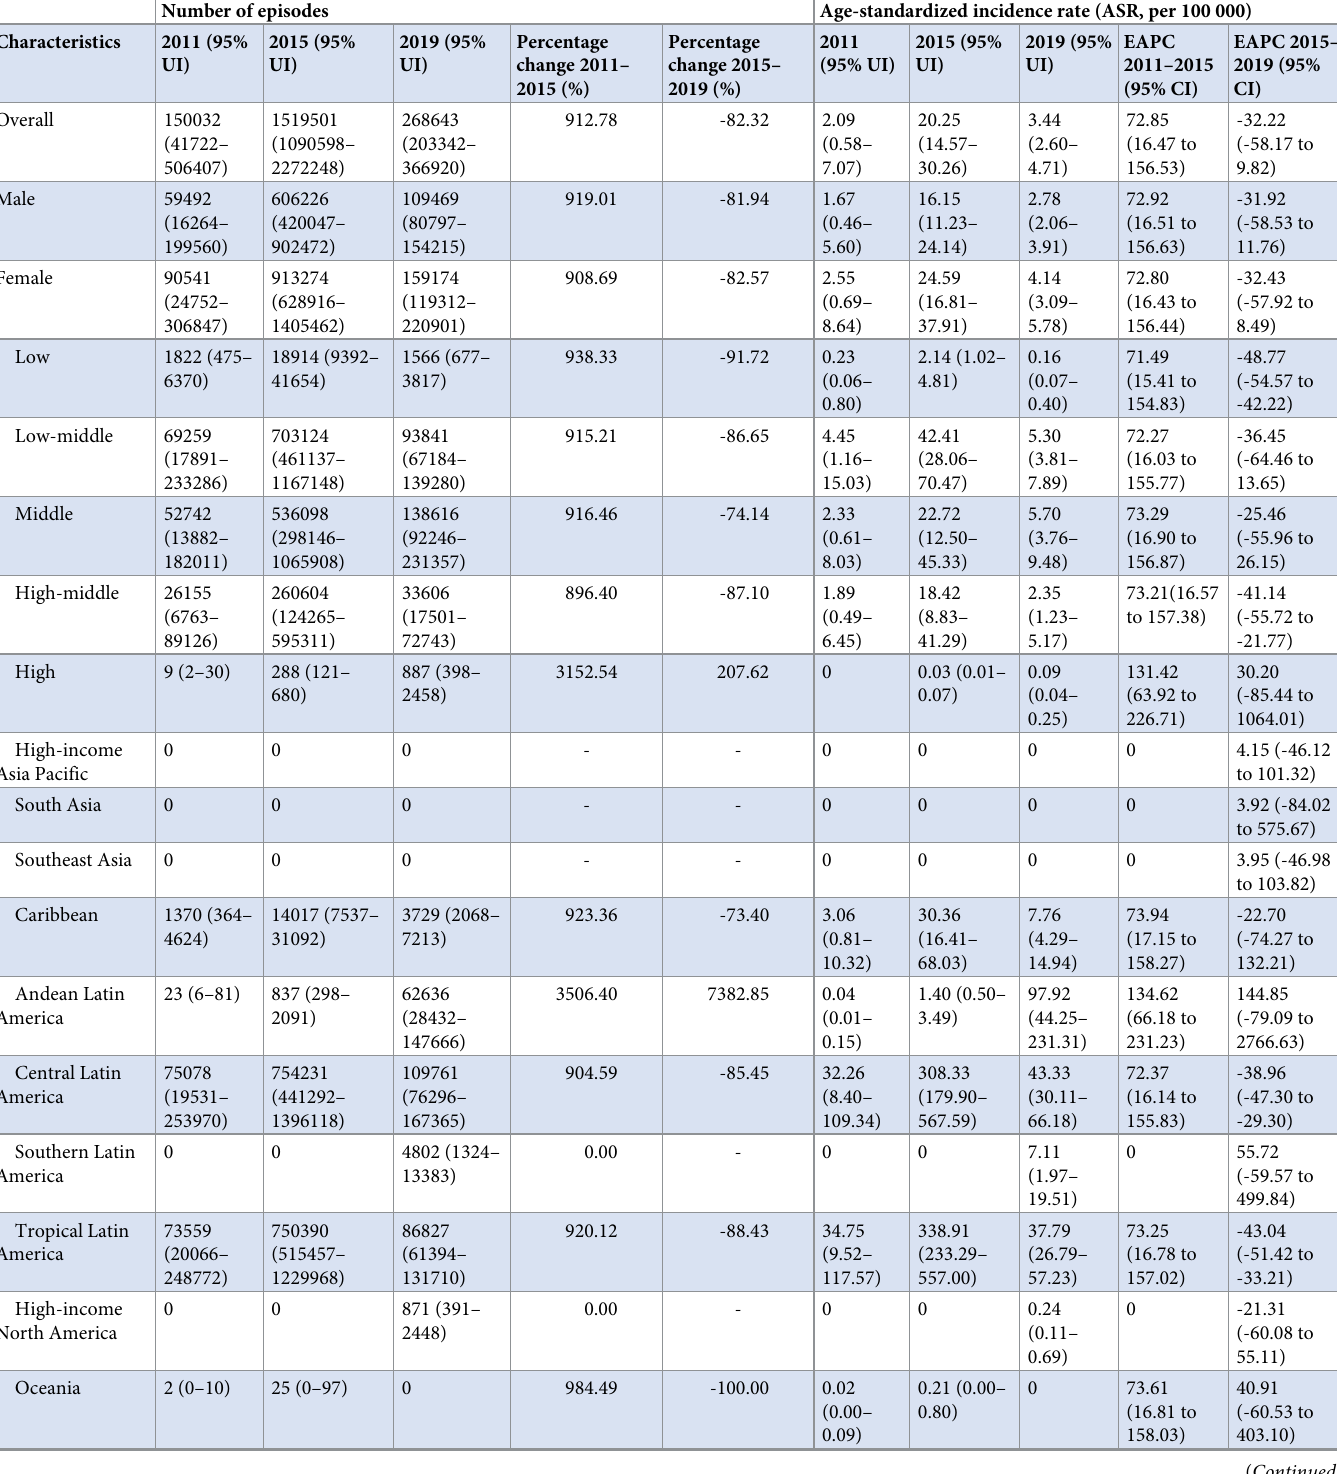
Table 1. The number of episodes and age-standardized incidence rates (ASR, per 100 000) of ZIKV infection in 2011, 2015 and 2019, and their temporal trends from 2011 to 2015 and trends from 2015 to 2019. Number of